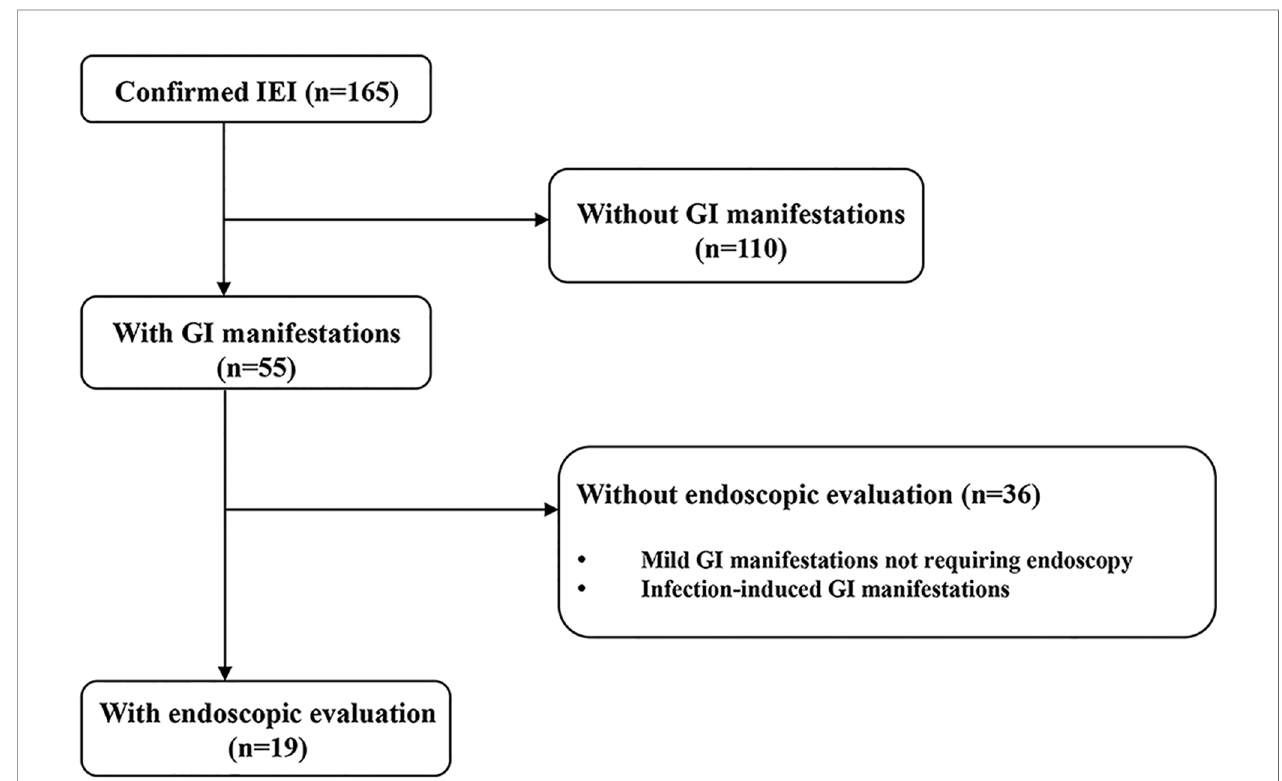
FIGURE 1 | Study fl ow diagram. IEI, inborn errors of immunity; GI,